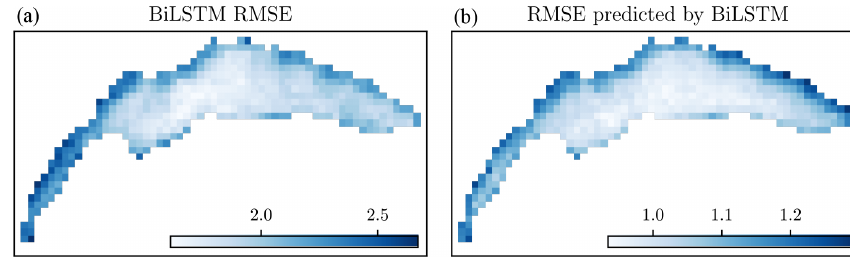
Figure 14. Spatial distribution for the BiLSTM RMSE (a) and the RMSE predicted by the BiLSTM (b)